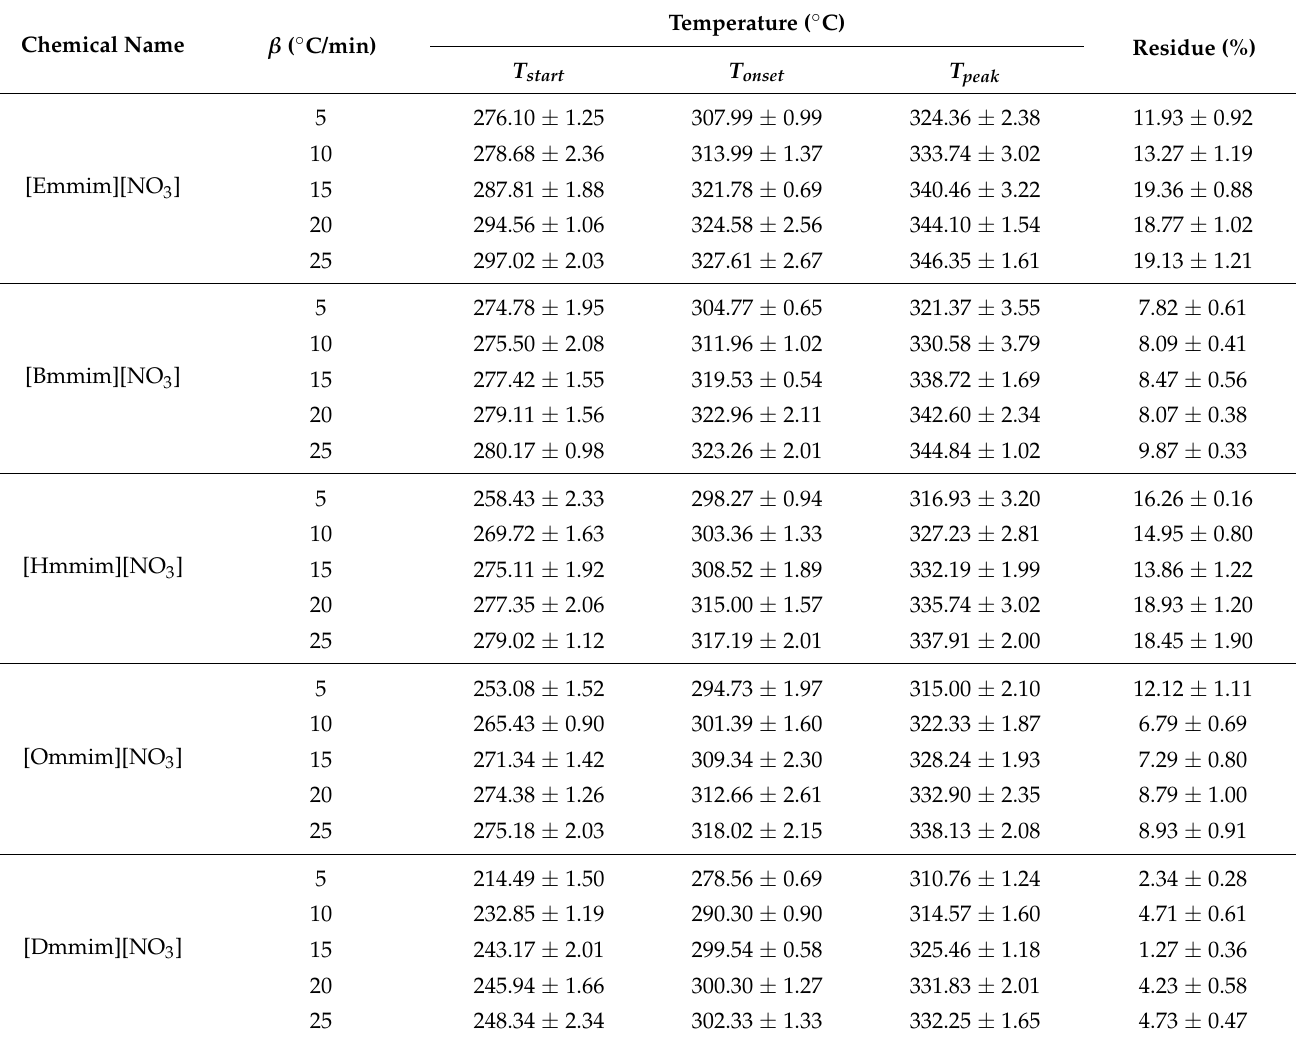
Table 2. Obtained mass loss parameters for five ionic liquids by